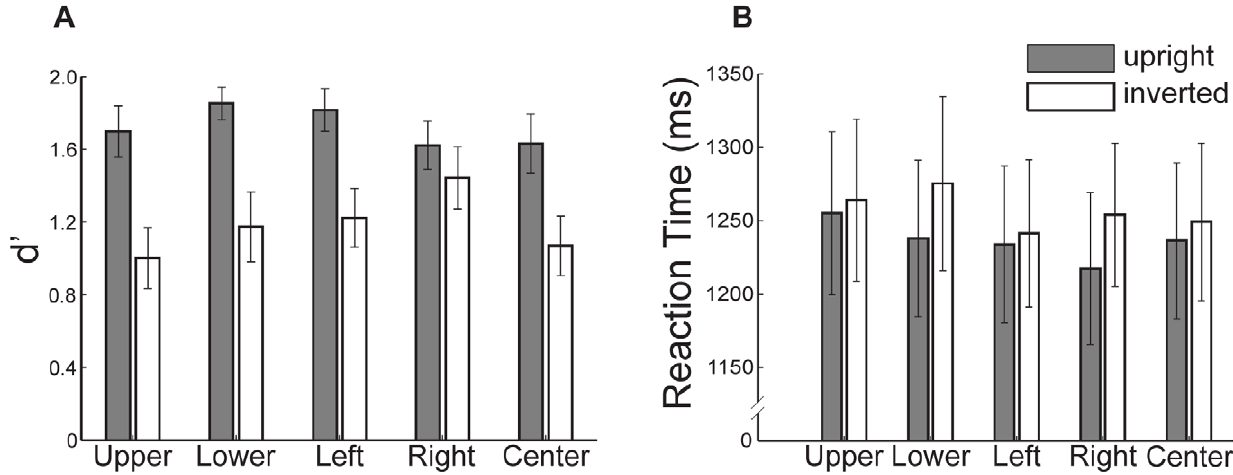
Figure 2. Effects of face inversion on recognition. ( a ) Face recognition, measured by d 9 , was significantly greater for upright than inverted faces. ( b ) Reaction time also showed an effect of inversion, with longer reaction times for inverted compared to upright faces. Error bars indicate the between-subjects standard error.